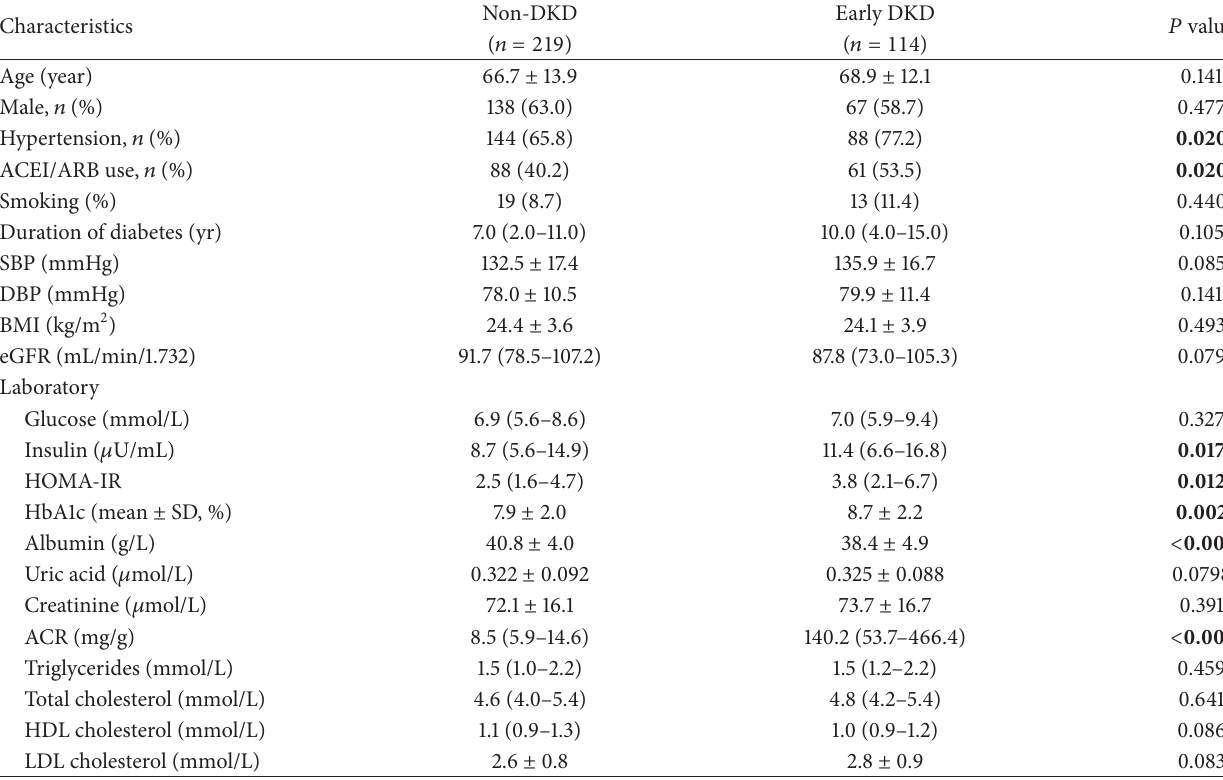
Table 1: The main clinical and biochemical characteristics of type 2 diabetic patients with or without early diabetic nephropathy.